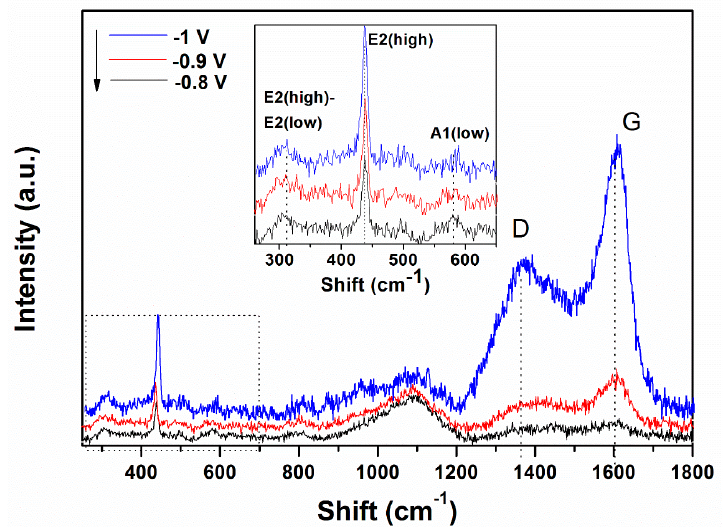
Figure 3. Raman spectra evolution of ZnO electrodeposited in presence of 10 mg L − 1 GO as a function of the applied deposition potential.